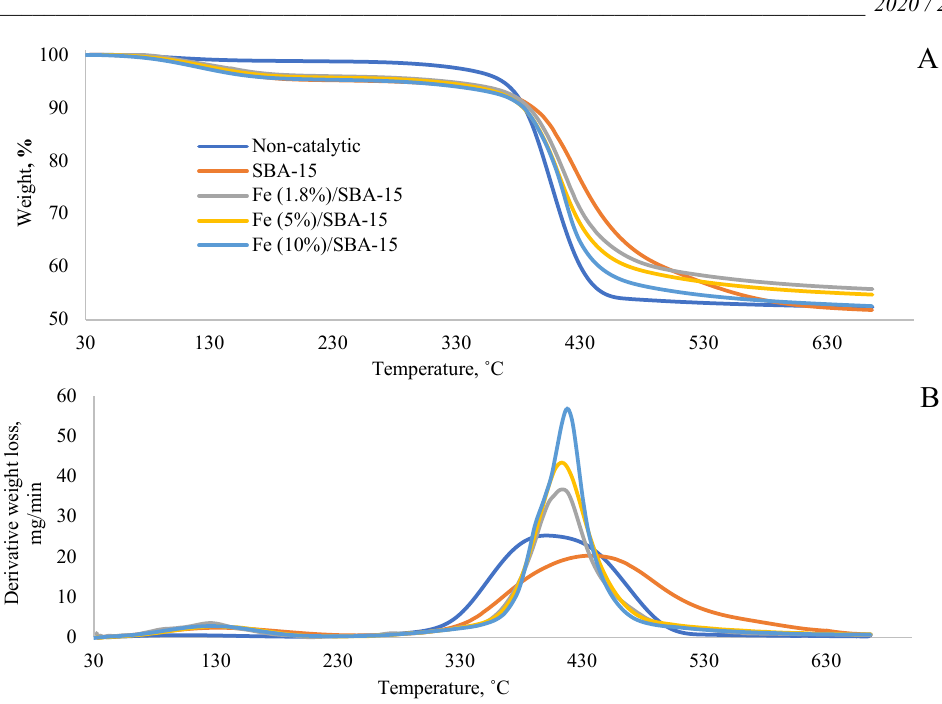
Fig. 3. TG (A) and DTG (B) curves for cellulose in catalytic and non-catalytic